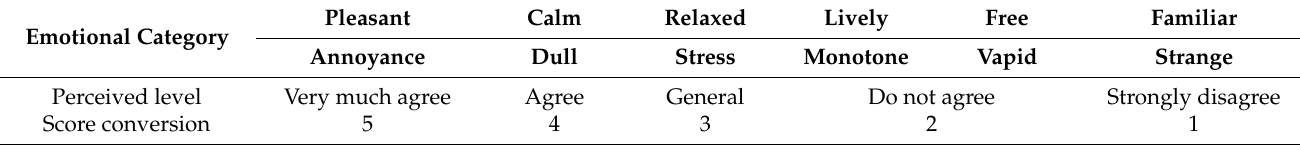
Table 3. Mood scale.